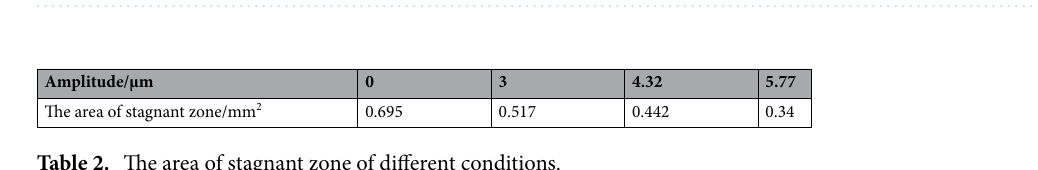
Figure 9. Calculation of the area of stagnant zone.